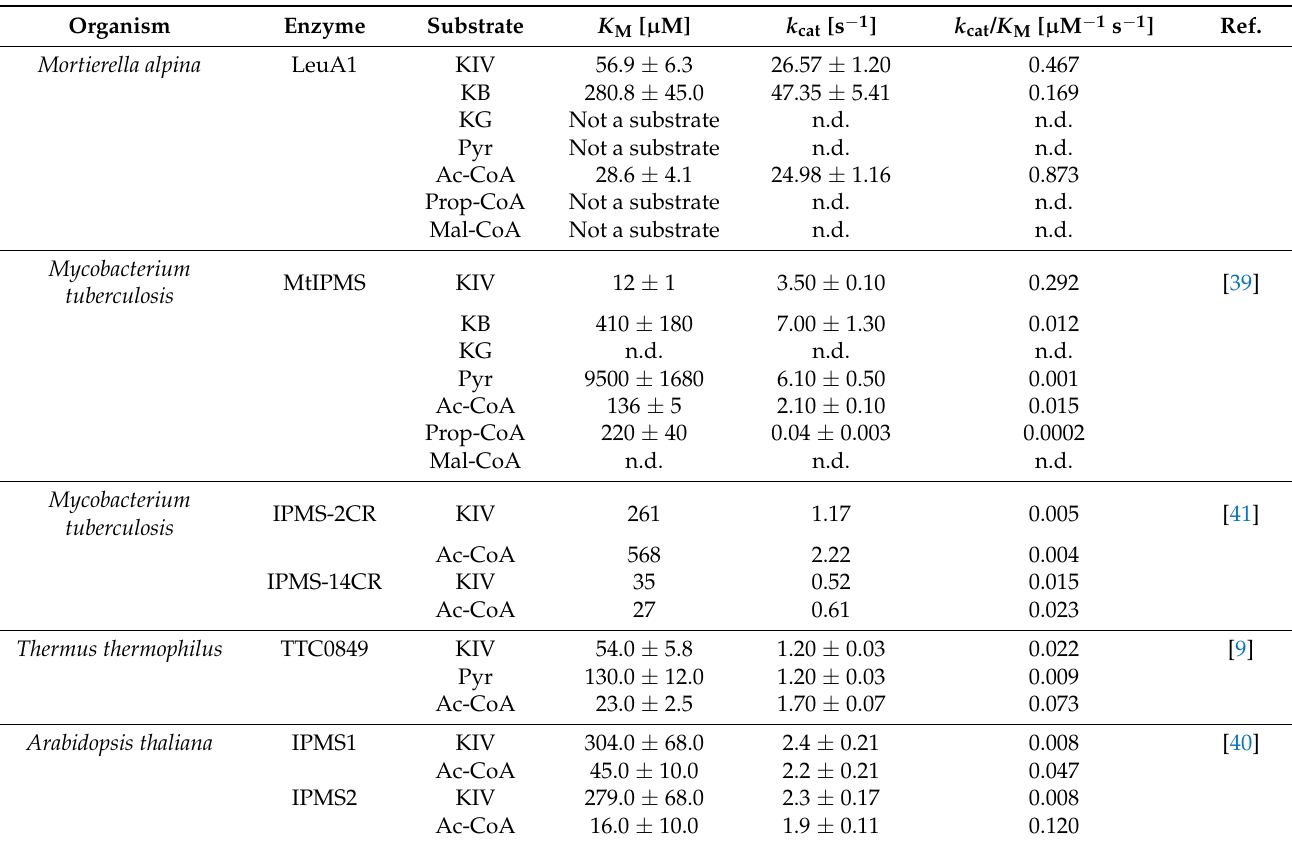
Table 3. Kinetic parameters of LeuA1 from M. alpina and related enzymes. Ac-CoA, acetyl-CoA; KB, α -ketobutyrate; KG, α -ketoglutarate; KIV, α -ketoisovalerate; Mal-CoA, malonyl-CoA; Prop-CoA, propionyl-CoA; Pyr, pyruvate.